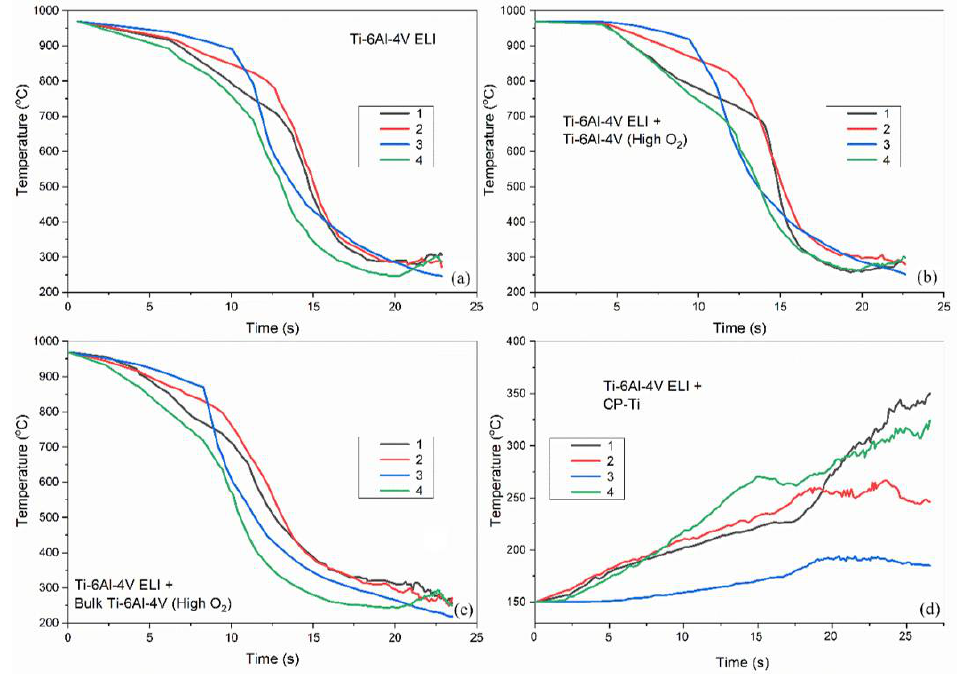
Figure 7. Temperature distribution at the four different points varies with time ( a ) Part 1, ( b ) Part 2, ( c ) Part 3, and ( d ) Part 4. The temperature distribution of the forged parts is given in Figure 7. The temperature variations of four different points of the parts are shown in Figure 7a–d. Figure 7a displays the temperature variation of a single material (Ti-6AL-4V ELI) which varied temperatures with respect to time. Temperatures varied from 970 to 250 °C in the forging process’s total duration (24 s). Figure 7b shows the initial temperature declined gradually up to 5s due to the presence of coating material (Ti-6AL-4V (high O 2 )) up to 500 microns; after that, it reduced drastically from 800 to 350 °C during the forging process. It may be due to the higher thermal expansion and conductivity of Ti-6AL-4V ELI material. For all four points, P1, P2, P3, and P4, in Figure 7a,b, showed no significant differences in temperature distri- bution. For Part 3, P3 is located in the middle of the forged part and had direct exposure to air rather than the upper die. Hence, the initial temperature was maintained for up to 15 s; after starting contact with the upper die material, the temperature reduced gradually due to direct heat transfer. P2 was close to the upper die. Direct heat transfer may be the reason for temperature variations, as shown in Figure 7c. In the case of Part 4, at the higher temperature, the shell materials had a very low thermal expansion and Young’s modulus; the material deformed rapidly and pushed out all materials during the forging process. It may be the reason that the process was not able to perform at higher temperatures. Hence, the forging process should start at 150 °C. P3 maintained the same temperature up to 15 s, shown in Figure 7c; after that, the temperature reduced gradually, and the upper die and P3 did not have contact directly, which may be the reason for the steady-state tem- perature.